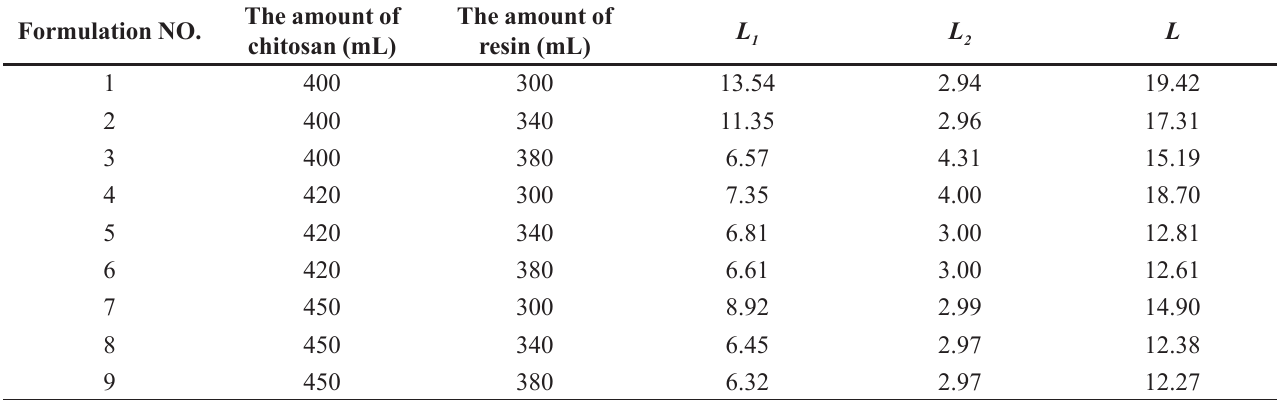
TABLE IV - Experimental runs and the determined values of L Formulation NO.